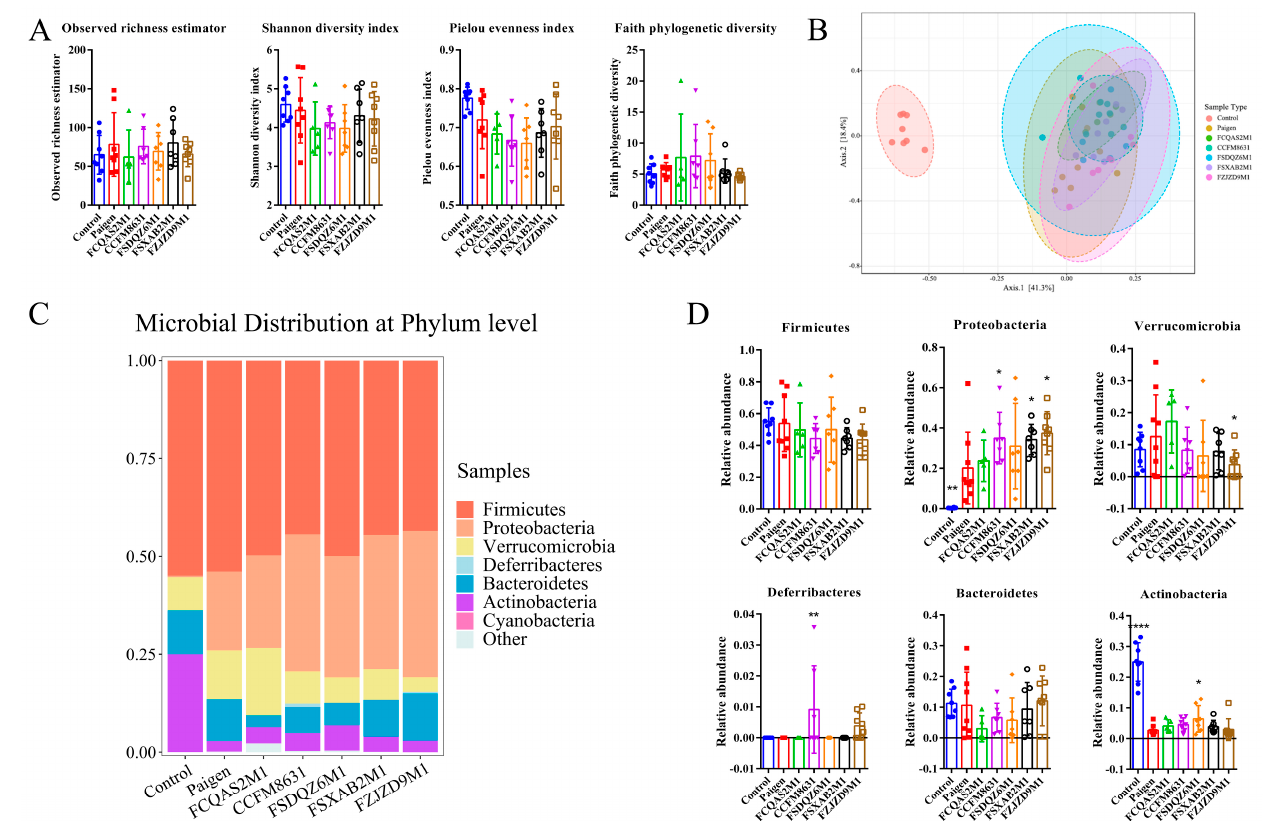
Figure 5. Lactobacillus and Bifidobacterium modulated the composition of intestinal flora. ( A ) α diver- sity of microbial faeces. ( B ) Principal coordinates analysis of microbial taxa. ( C ) Microbial distribution at phylum level. ( D ) Relative abundance of the phylum level. n = 8. Compared with Paigen group, * p < 0.05, ** p < 0.01, **** p < 0.0001.